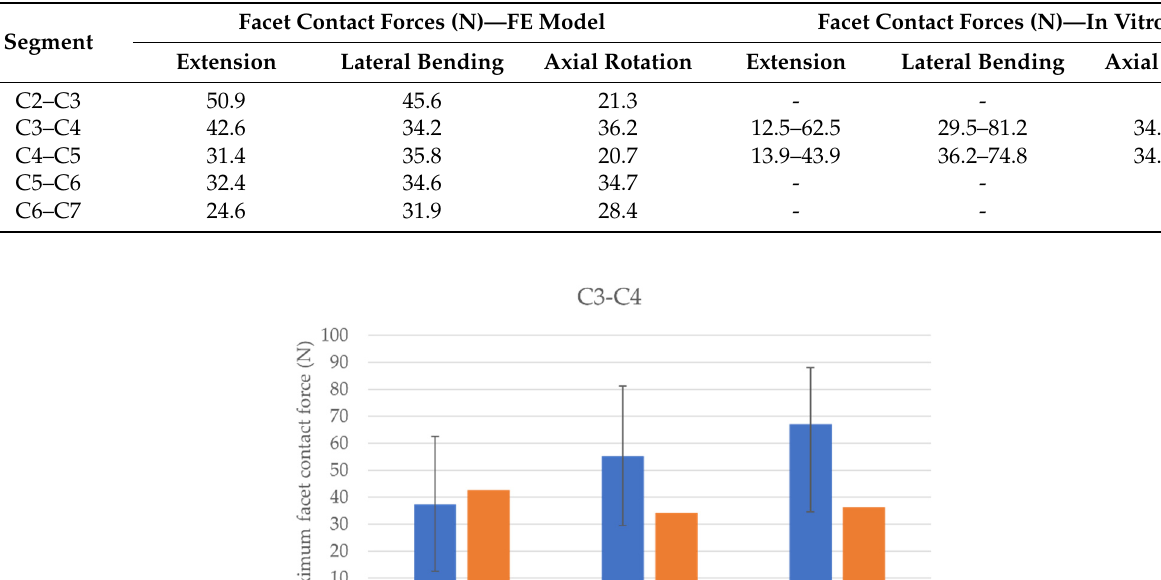
Table 3. Comparison of the facet contact forces between the FE model results and the in vitro results reported in the literature [27] .